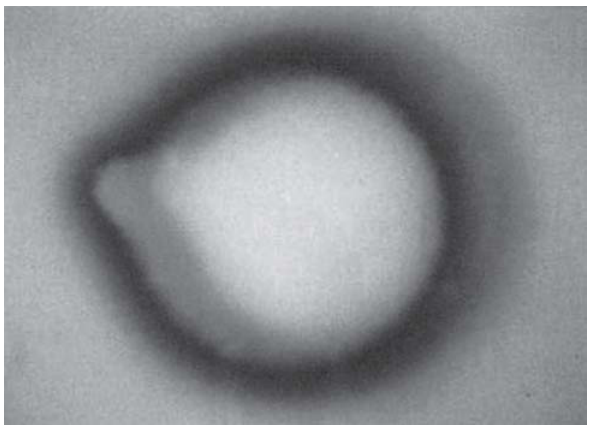
FIGURE 1- Intense blue ring around the test substance indicating genotoxicity in the SOS chromotest. Positive control with 4NQO against strain PQ37